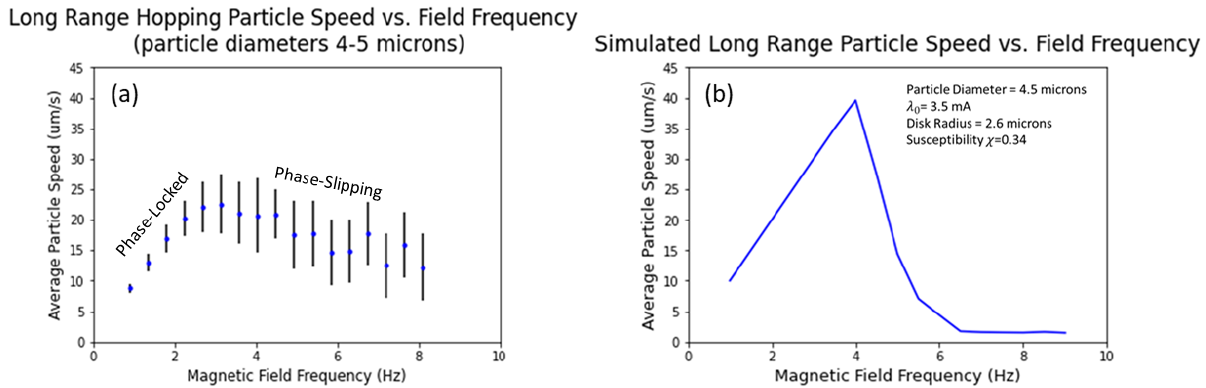
Figure 5. ( a ) Average particle speed as transported on the permalloy disk array. The particles used are Spherotech PMS-40-10. From 0 to 3 Hz, the motion is phase-locked, and beyond 3 Hz, the motion is phase-slipping, as the speed no longer increases with the magnetic field frequency. ( b ) Simulation of the speed response of a single particle.